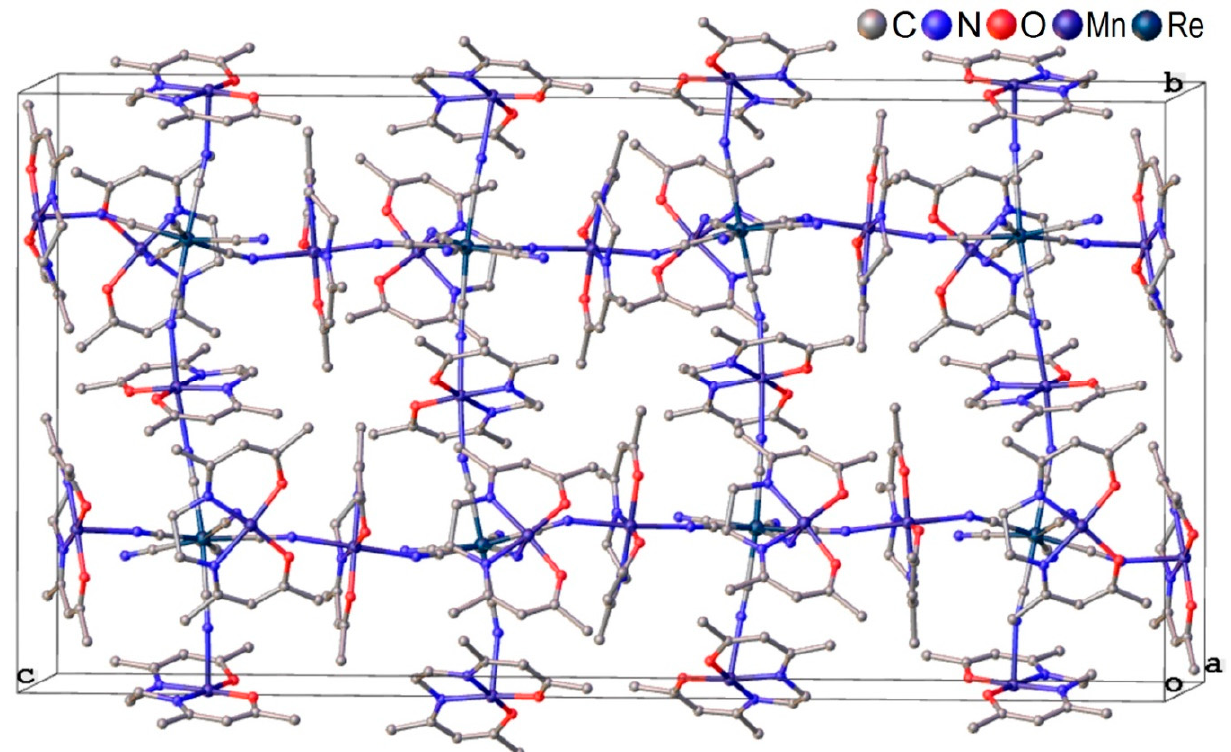
Figure 4. Unit cell of 11 ( P 2 1 / n , a = 10.6492(3) Å, b = 21.8027(5) Å, c = 41.839(1) Å, β = 92.570(1)°, V = 9704.5(4) Å 3 ) projected on the bc plane. The apical axes of [Re(CN) 7 ] 3 − units (slightly distorted PBPs) are oriented along the b axis, suggesting that b is the easy magnetic axis (see the text) [44].